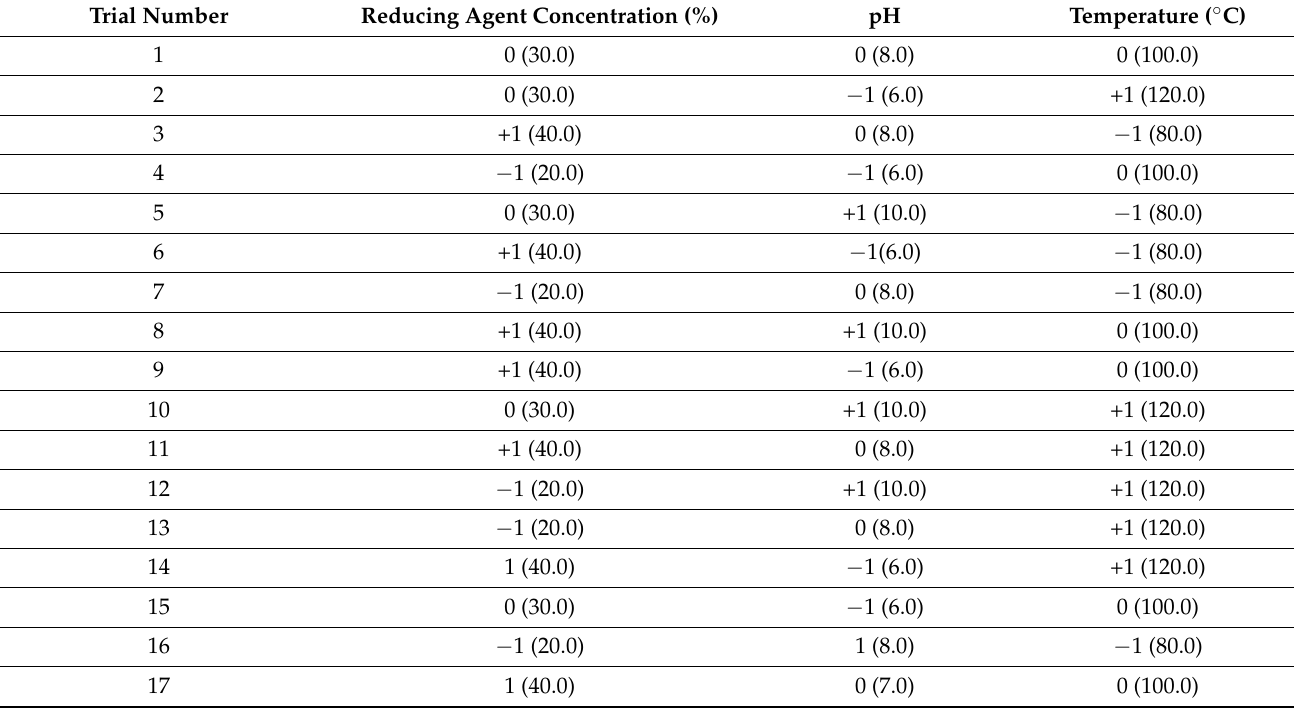
Table 8. Box–Behnken design of Mo-capped AgNP